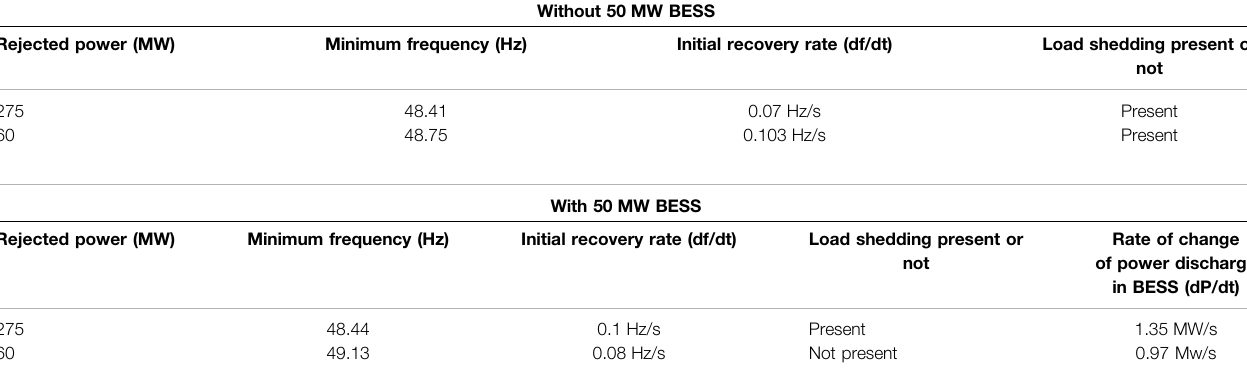
TABLE 1 | Frequency and power